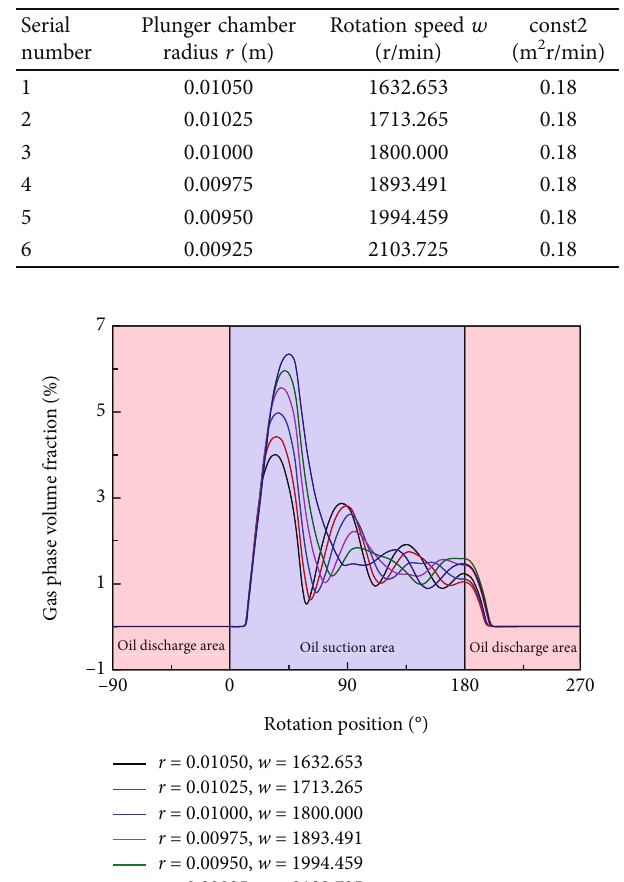
Table 4: Combination list of plunger chamber radius and rotation speed.